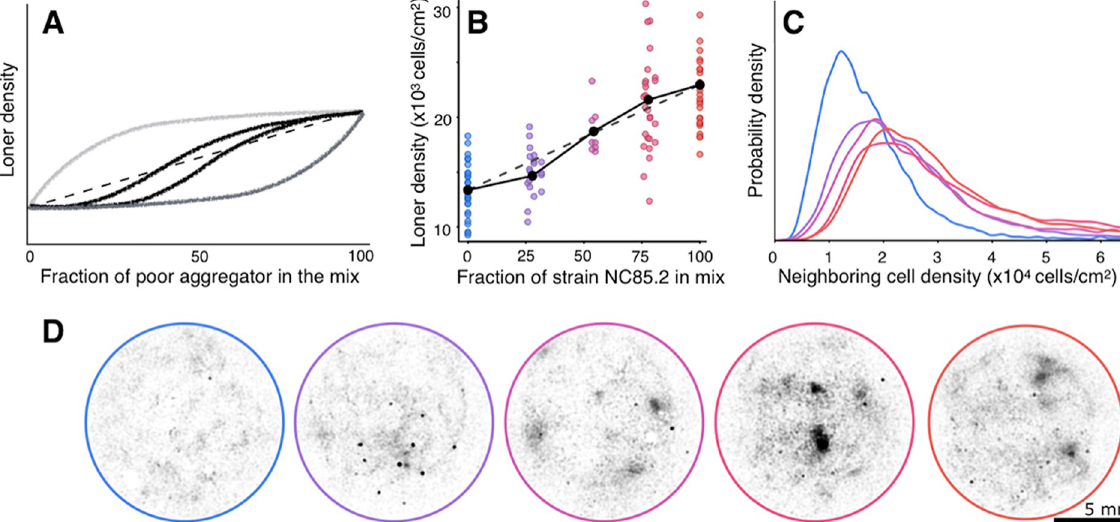
Fig 4. Co-occurring strains interact during development. (A) Schematic of the range of theoretically predicted loner densities at different mix proportions of 2 co-occurring strains (thick curves). Dashed line, expected loner densities if cells commit to aggregation independent of the identity of their neighbors. (B) Experimentally observed loner densities for different mix proportions of a better (NC28.1, blue) and a worse (NC85.2, red) aggregating strain in 3% agar. Black points, mean loner densities for each of the 5 proportions. Dashed line, same as in (A). Solid lines, piecewise linear regressions, which deviate significantly from the linear fit ( p = 0.019; see Materials and Methods). The significant departure from the linear fit is reinforced by bootstrapping and maximum likelihood analyses (see S7 Fig and Materials and Methods). The endpoints (0% and 100%) represent an independent replicate of the experiments in the framed portion of Fig 1E. (C) Experimentally observed spatial patterns of each mix proportion are characterized by the local cell density around each cell (see Materials and Methods). Narrower distributions (NC28.1, blue curve) correspond to more homogeneously distributed loners. Broader distributions (NC85.2, red curve) correspond to more clumped loners. (D) Experimentally obtained loner position maps are shown for each of the mixed proportions. Colors in (C) and (D) correspond to colors in